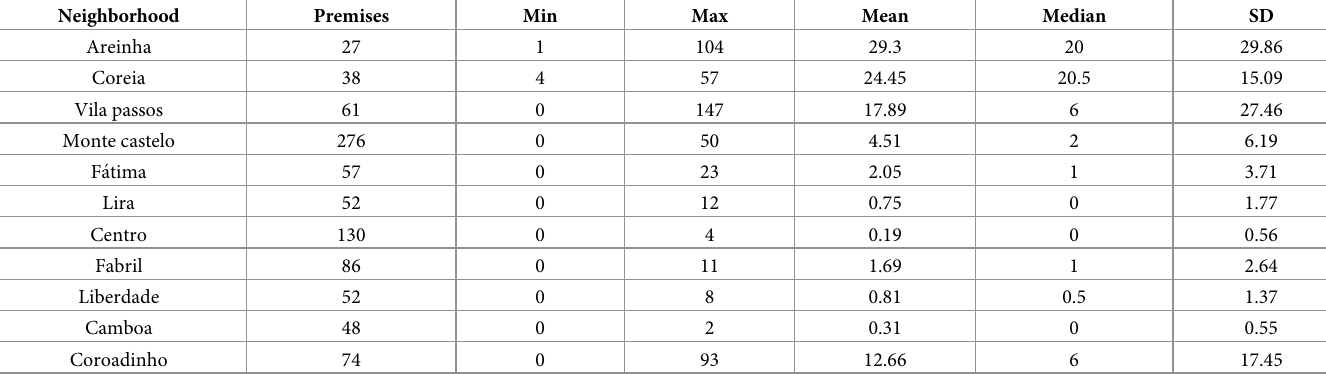
Table 2. Total Culex quinquefasciatus females collected in S ã o Luı´s, MA, Brazil, between July 2016 and October 2017.